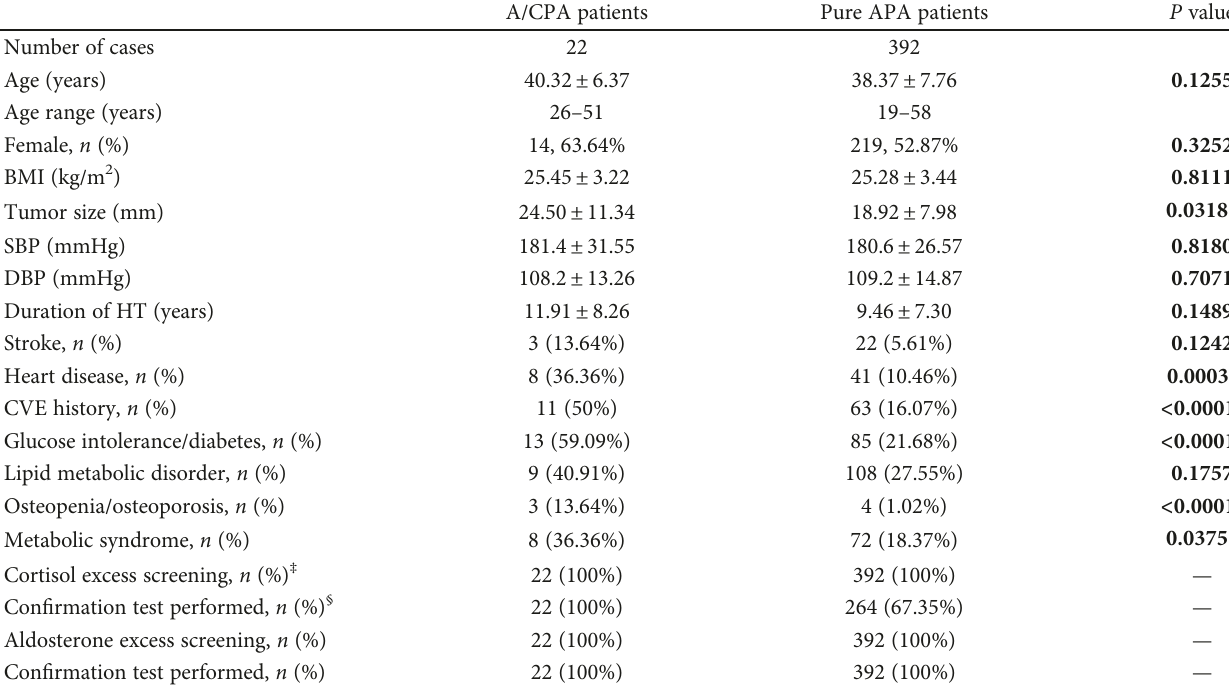
Table 1: Clinical data of A/CPA patients and pure APA